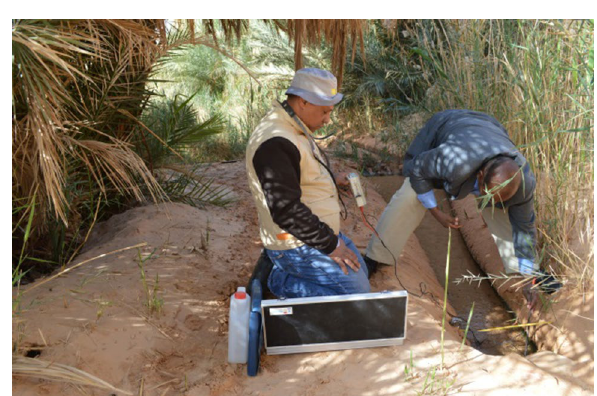
Fig. 2 February 4, 2018, gauging the foggaras El Hadj Amar Kebir at the kasria level. (photo. Authors 2018)